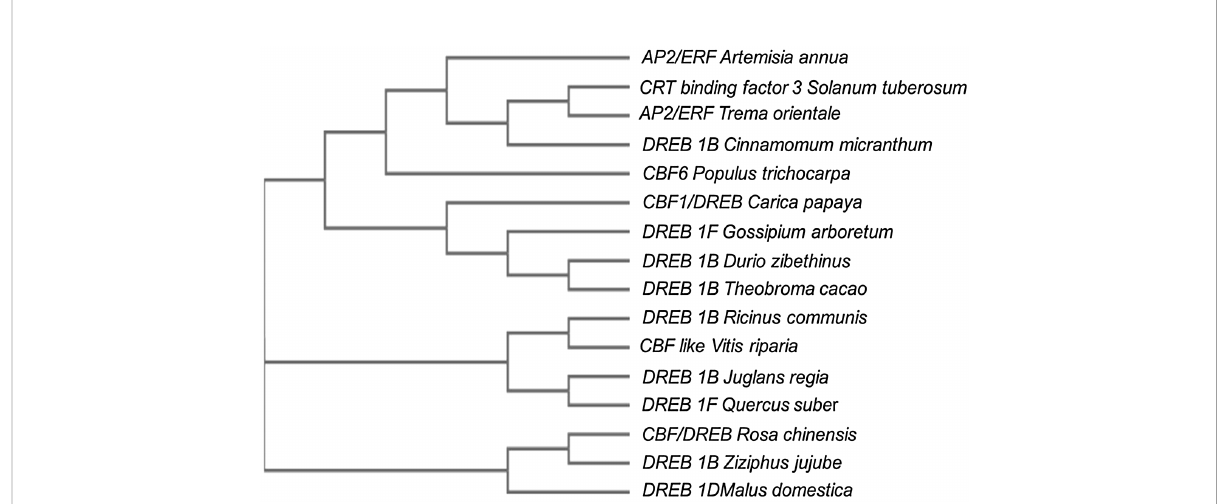
FIGURE 4 Phylogenetic tree of CBFs from different plants. Carica papaya CBF1 (XP_021908755.1), Juglans regia DREB 1B Like (XP_018812676.1), Quercus suber DREB 1 F Like (XP_023913339.1), Durio zibethinus DREB 1B Like (XP_022744533.1), Gossypium arboretum DREB 1F Like (XP_017622119.1), Ziziphus jujube DREB 1B Like (XP_015901948.1), Theobroma cacao DREB 1B Like (EOY08142.1), Cinnamomum micranthus DREB 1B Like (RWR82367.1), Ricinus communis DREB 1B Like (EEF33807.1), Populus trichocarpa C-repeat binding factor 6 (ABO48367.1), Vitis riparia CBF -Like transcription factor (ARD27023.1), Rosa chinensis putative CBF / DREB transcription factor (ABQ53132.1), Artemisia annua AP2 / ERF domain- containing protein (PWA50609), Solanum tuberosum CRT binding factor 3 (ACB45095.1), Trema arientale AP2 / ERF domain-containing protein (PON57830.1), Malus domestica DREB 1D (XP_028948628.1) (FIGURE adapted from Maurya et al.,